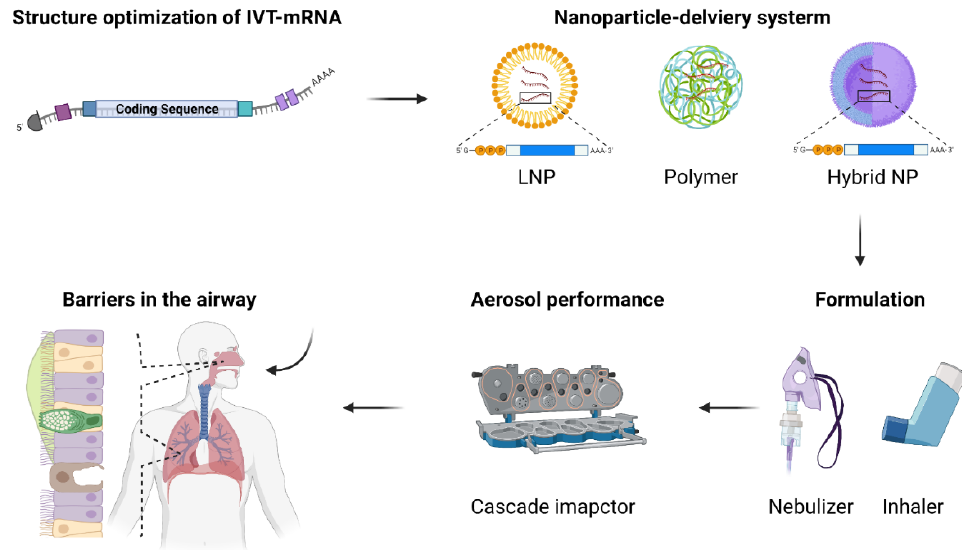
Figure 2. Schematic illustration of key factors associated with the technology development of IVT- mRNA vaccines via the respiratory route. IVT-mRNA structural elements, including elongation of the poly(A) tail, the 5′ cap, the structure of UTRs, and the ORF with optional incorporation of modified nucleotides, are optimized to enhance the stability and reduce the innate immunogenicity. Nanoparticle-based carriers are designed to facilitate the delivery of IVT-mRNA across the barriers in the airway. Liquid aerosol or dry powderformulations are then developed with the identification of a suitable inhalation device (nebulizer or powder inhaler) for clinical applications. The aerosol performance, IVT-mRNA stability after aerosolization, immunogenicity, and vaccine efficacy of the inhaled formulation should be thoroughly characterized and evaluated.